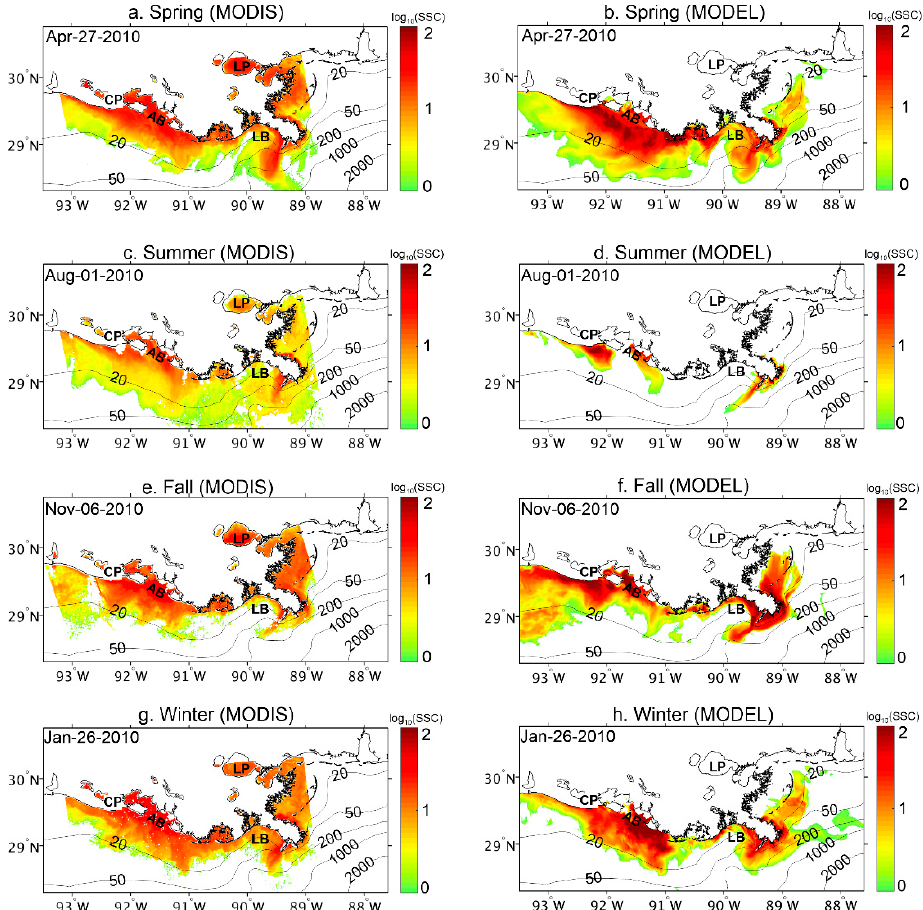
Figure 8. Comparison between MODIS (aqua)-derived surface SSC (left panel) and model-simulated surface SSC (right panel) in spring ( a and b ), summer ( c and d ), fall ( e and f ), and winter ( g and h ) in 2010, during which the number of good quality satellite images (no sun glint and cloud free) are largest. The exact date is shown at upper left of each panel. Unit: mg/L.